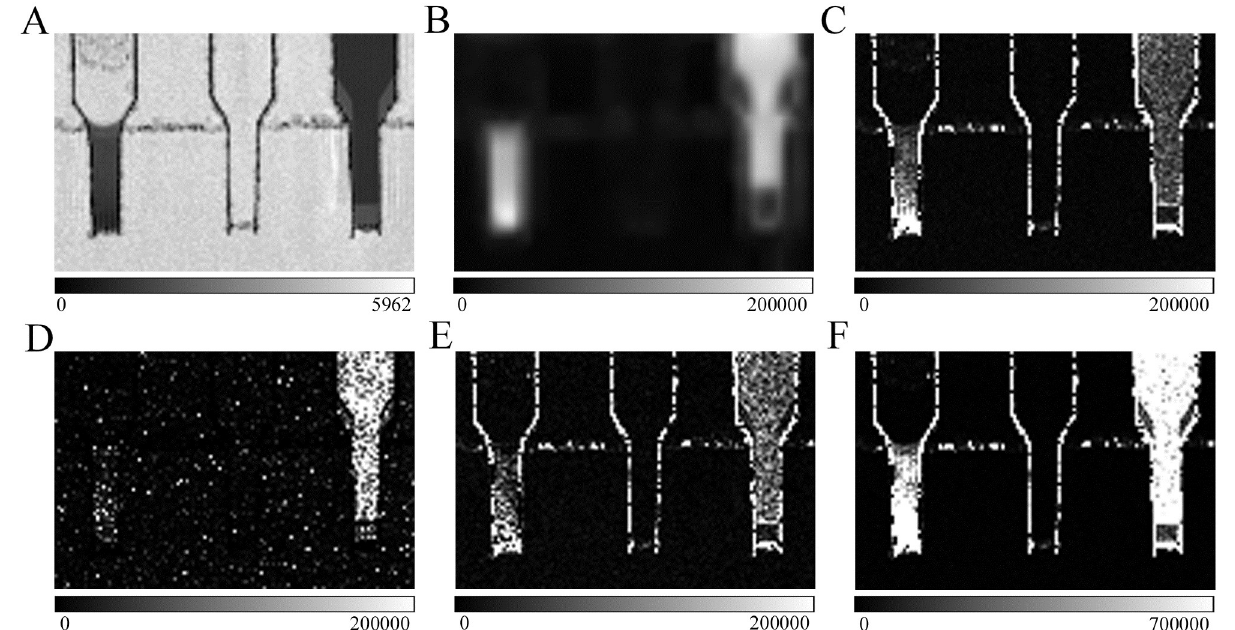
Fig 2. Comparison between several types of images for different phantoms. (A) ADC b . (B) DKI. (C) ASM/A 3 . (D) ASM/S 3 . (E) PASM/A 3 . (F) ASM/ A 5 . From left to right in every image, phantoms are high-cellularity bio-phantom, physiological saline phantom and 120 mM polyethylene glycol phantom. ADC, apparent diffusion coefficient; ADC b , ADC basic; DKI, diffusion kurtosis image; ASM, ADC subtraction method; ASM/A 3 , ASM division by ADC b three times; ASM/S 3 , ASM division by standard deviation image three times; PASM/A 3 , positive ASM division by ADC b three times; ASM/A 5 , ASM division by ADC b five times.